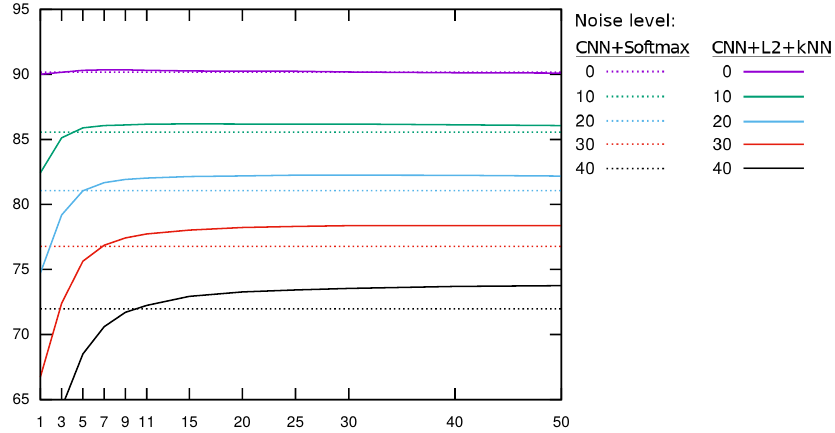
Figure 3. Average F 1 (%) accuracy ( y -axis) over all datasets with respect to the value of k ( x -axis) at different noise